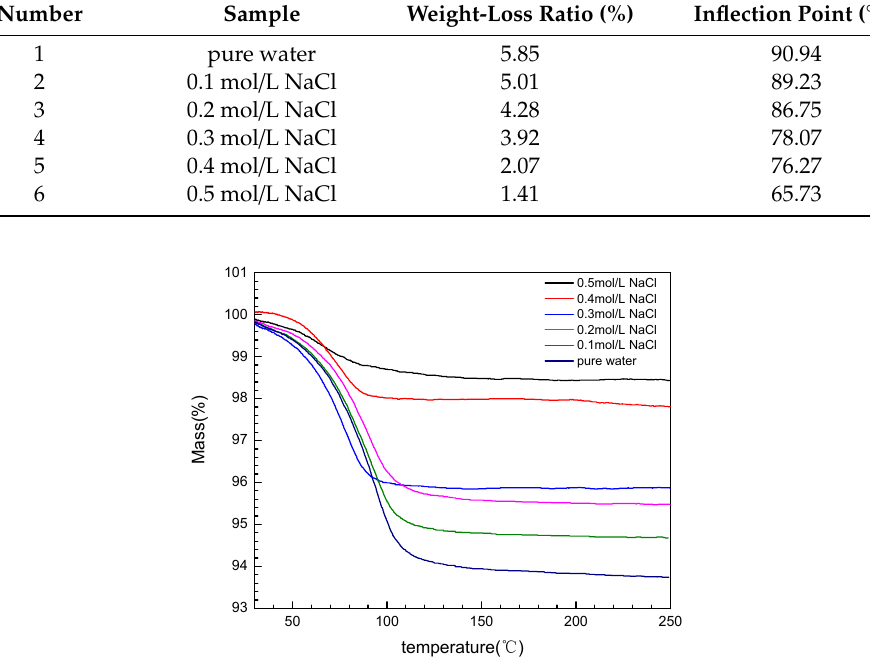
Figure 2. TG curves of dispersed montmorillonite samples.